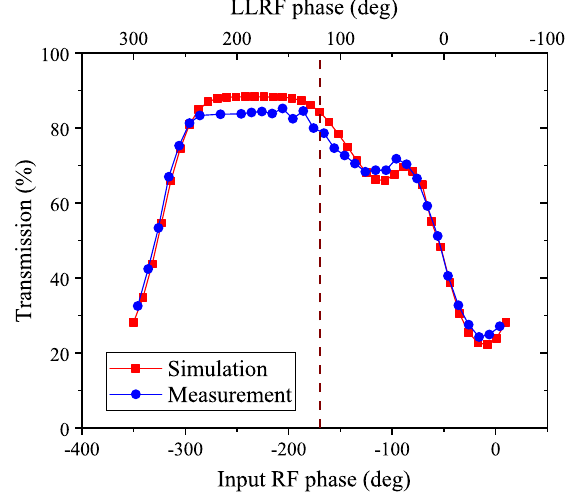
FIG. 14. Simulated transmission from the entrance of the BMS to the exit of the IH-DTL versus rf phase at 220 kW. The vertical red dashed line indicates the operating phase of the IH-DTL.